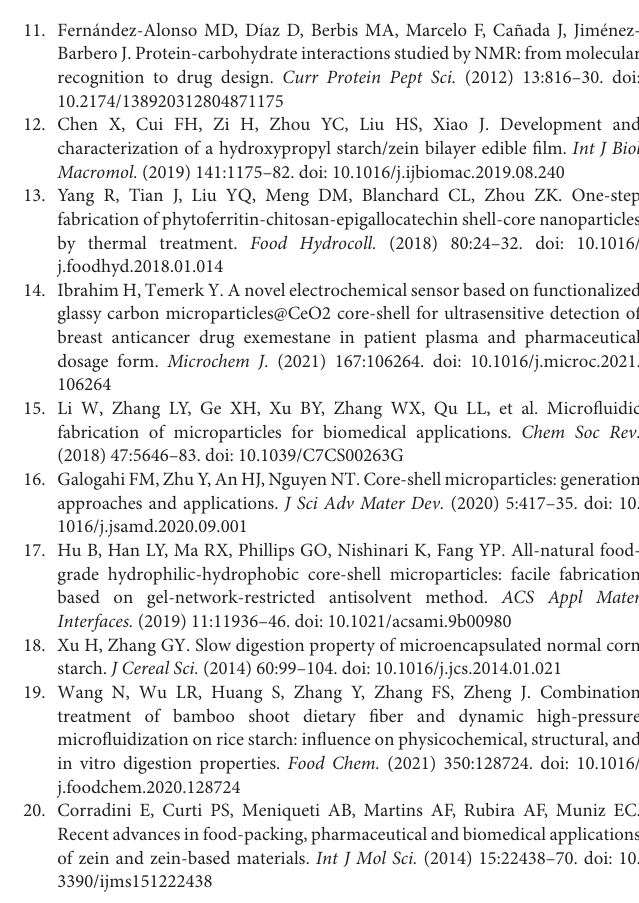
Supplementary Table 1 | Data sheet of the particle size distribution of native corn starch, unshelled swollen corn starch granules, and core-shell starch/zein microparticles crosslinked by TGase for different times (0, 1, and 2 h).